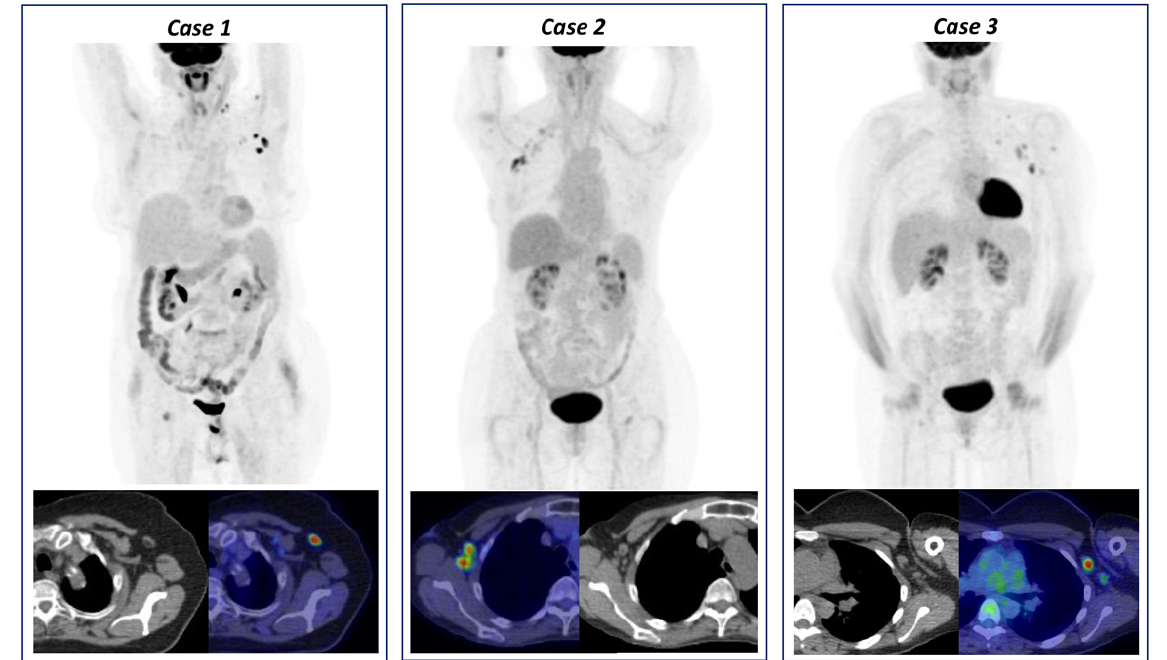
Figure 2. Three cases of vaccine-associated hypermetabolic lymphadenopathy (VAHL) detected on [ 18 F]FDG PET/CT. Case 1: [ 18 F]FDG PET/CT performed in a 67-year-old woman for left breast